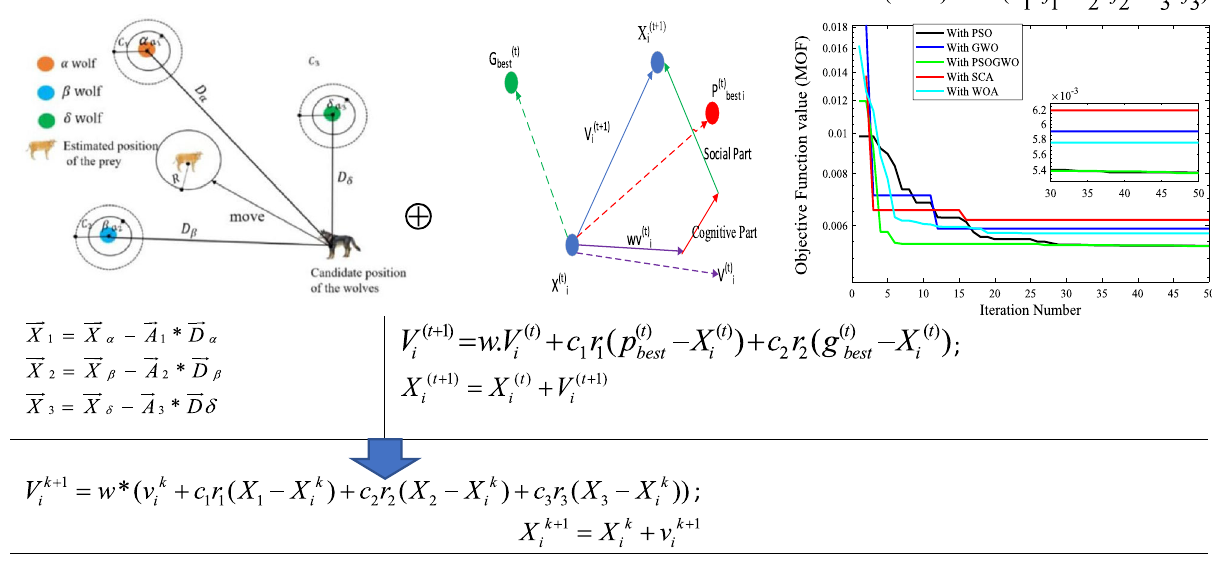
Figure 1. Graphical abstract of the proposed hybrid GWO-PSO based optimal placement and sizing